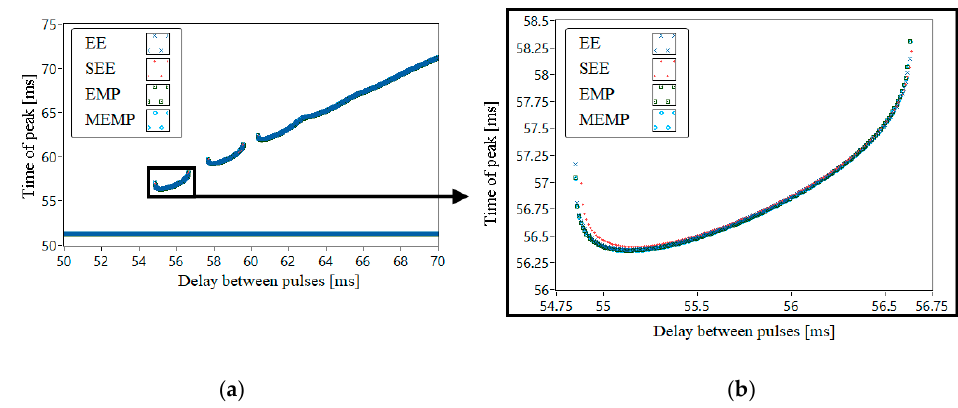
Figure 8. The refractory periods of the EE, SEE, EMP, and MEMP solvers of the system (1) while sending two pulse signals with amplitude A = 12 µA. The subplot shows the difference between the trajectories in a larger scale.